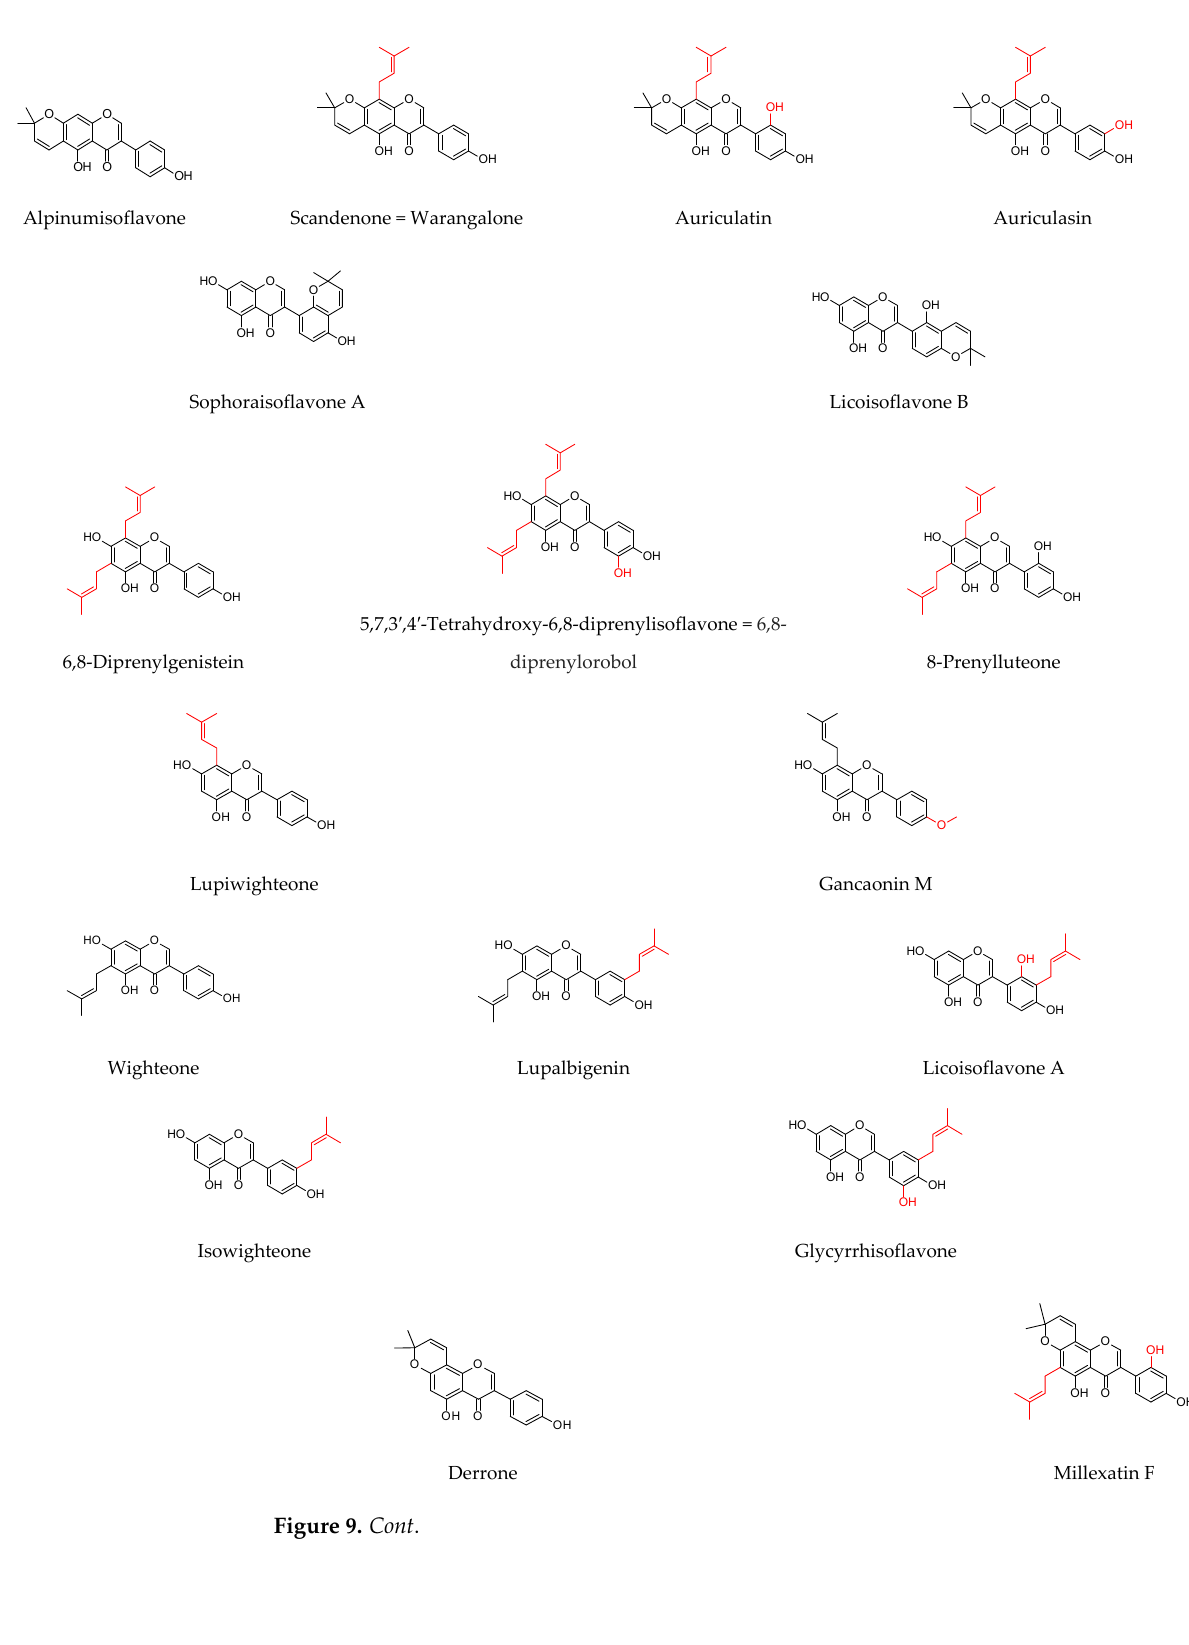
Figure 8. Structures of discussed flavones.